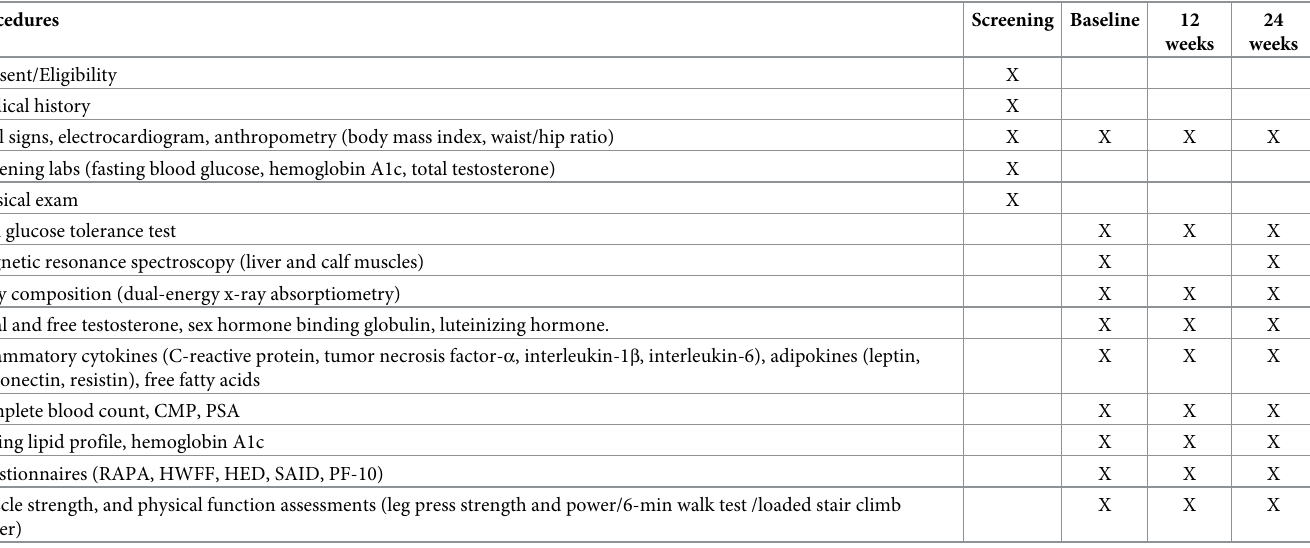
Table 1. Schedule of enrollment and assessments.